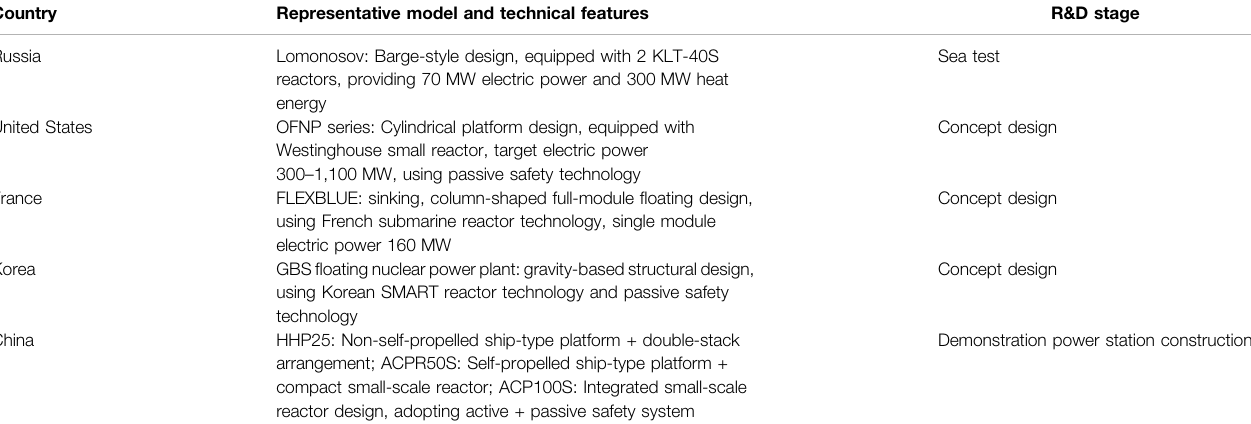
TABLE 1 | Progress in R&D of fl oating nuclear power plants Country